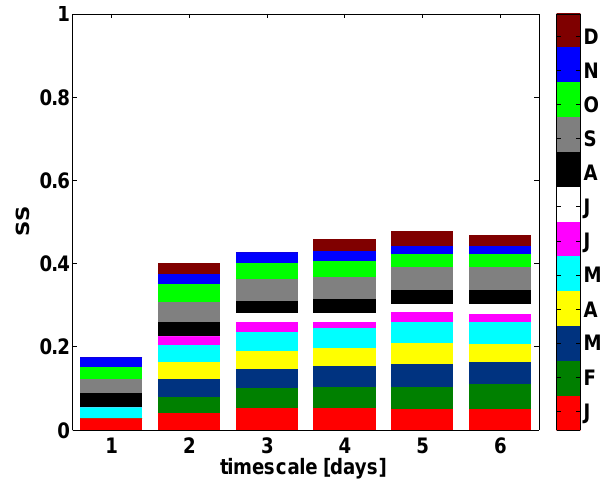
Figure 8. Values of SS for all assessed timescales (daily averages to 6-daily averages) and the 12 calendar months (colors of the bars, January to December), for which SS is found to be significant at each timescale. Shown here is the example of the predictor rea-ens- air for AWS1 daily air temperature as target variable. The values of SS are divided by 12 (the number of calendar months), such that the sum of the bars is equivalent to the average SS, at each of the timescales.